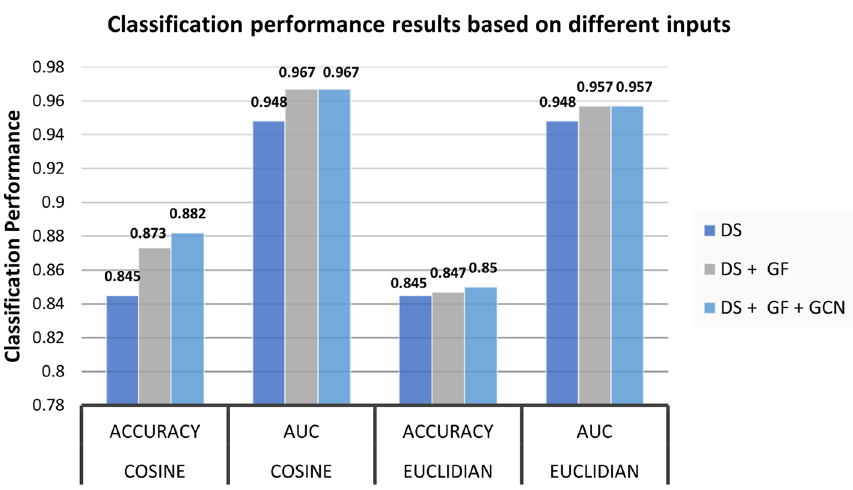
Fig. 3 Comparison of prediction results based on different